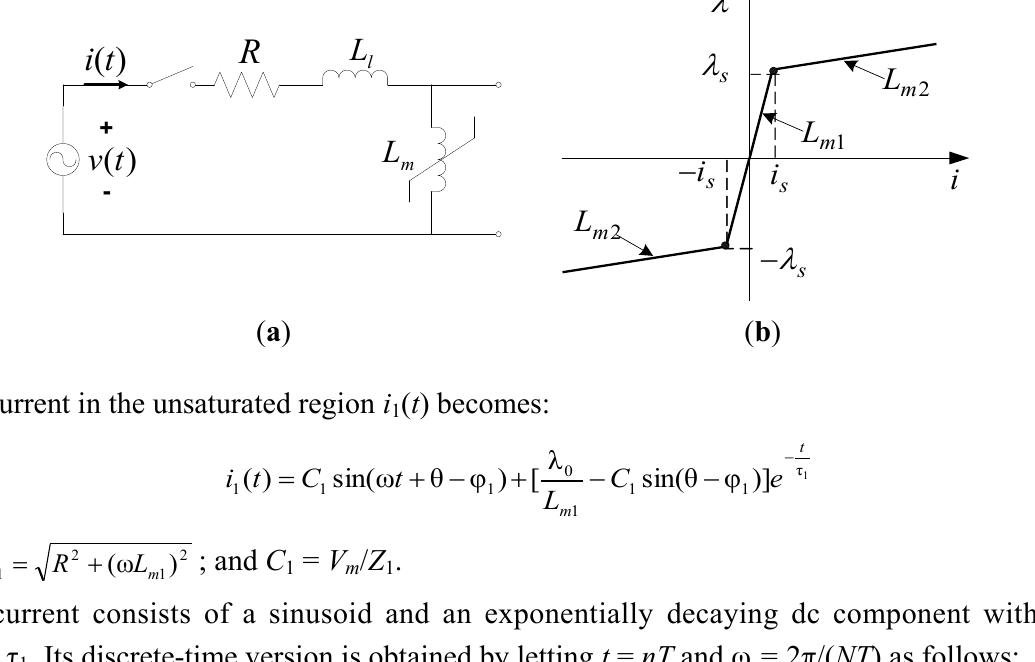
Figure 1. Simplified equivalent circuit and magnetisation curve of a transformer in the case of the magnetic inrush: ( a ) simplified equivalent circuit; and ( b ) magnetisation curve. L : leakage inductance; L : magnetisation inductance; R : winding resistance; v ( t ), i ( t ): l m voltage and current; λ : core flux at the saturation point; i s saturation point; L , L : magnetisation inductances in the unsaturated and saturated m 1 m 2